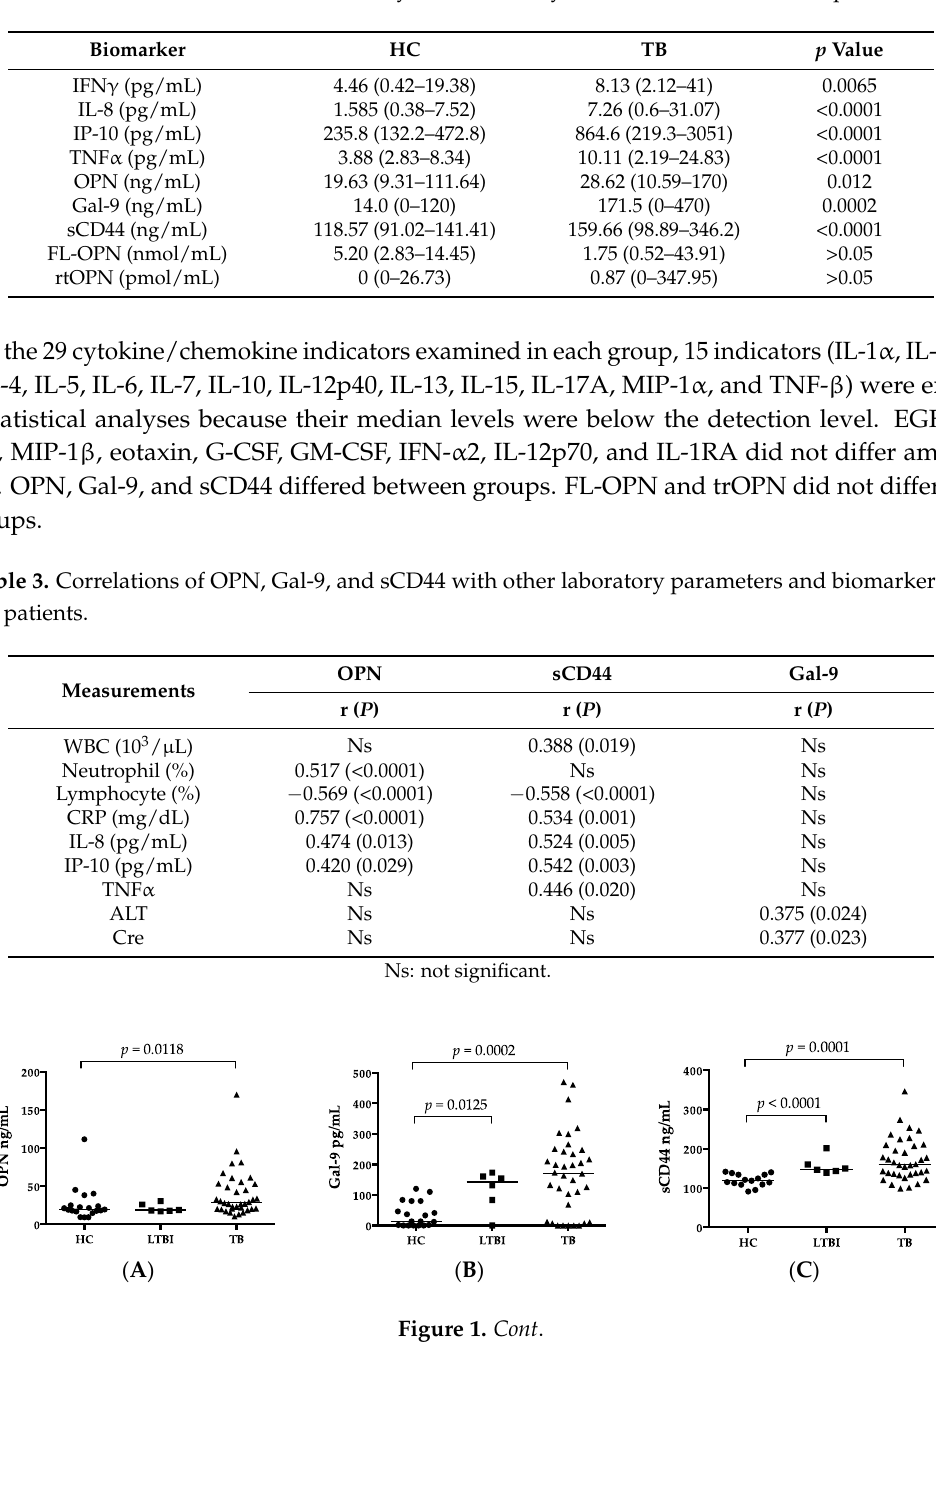
Table 2. Biomarker levels measured by Luminex assay and ELISA in HCs and TB patients.